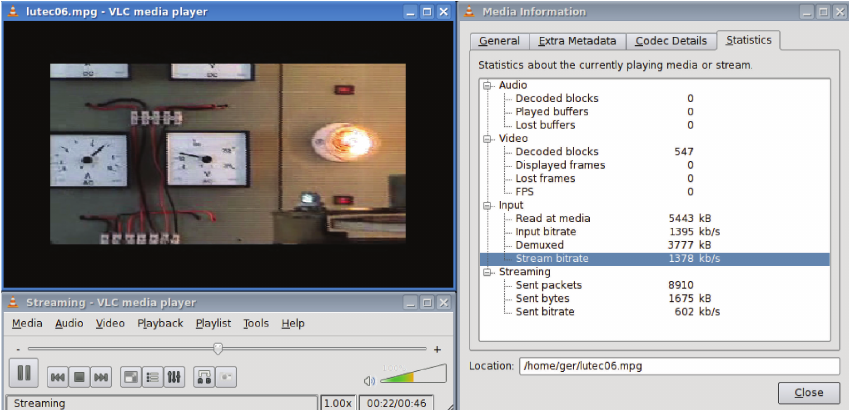
Figure 10: Example of video being received using the SDR platform with performance